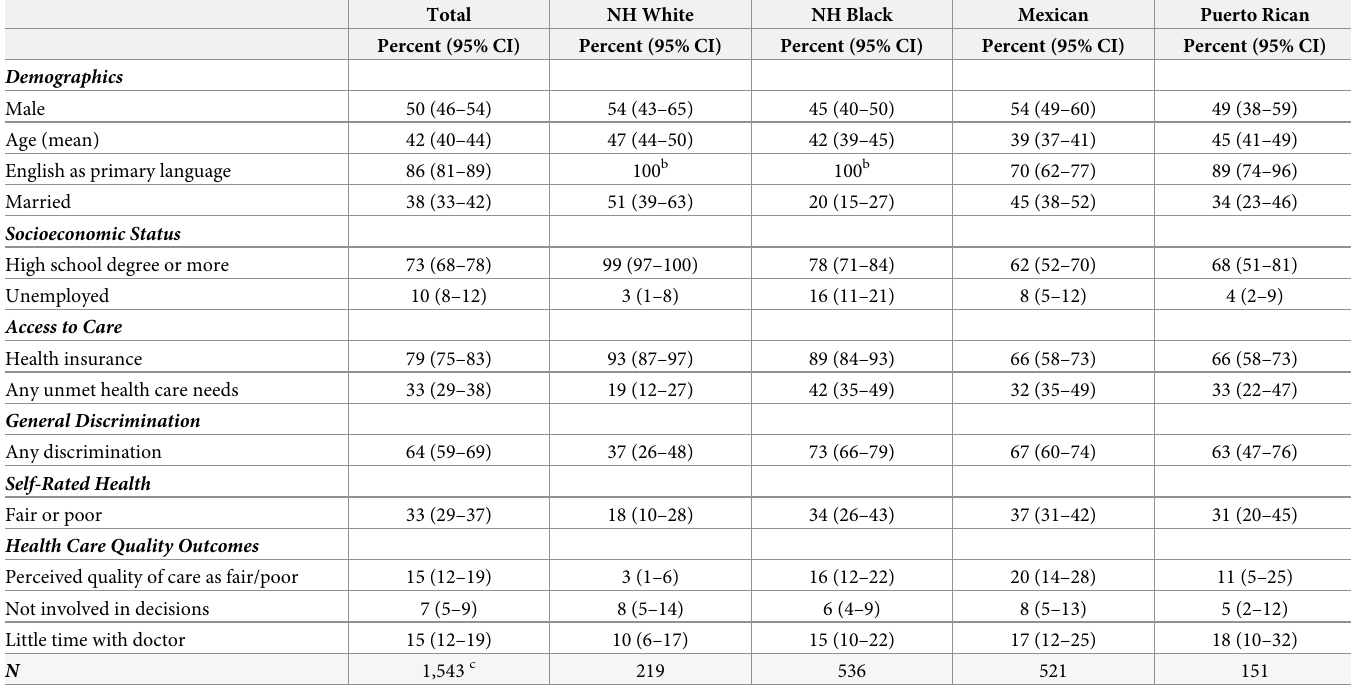
Table 1. Demographic, health, and health care characteristics by race/ethnicity a